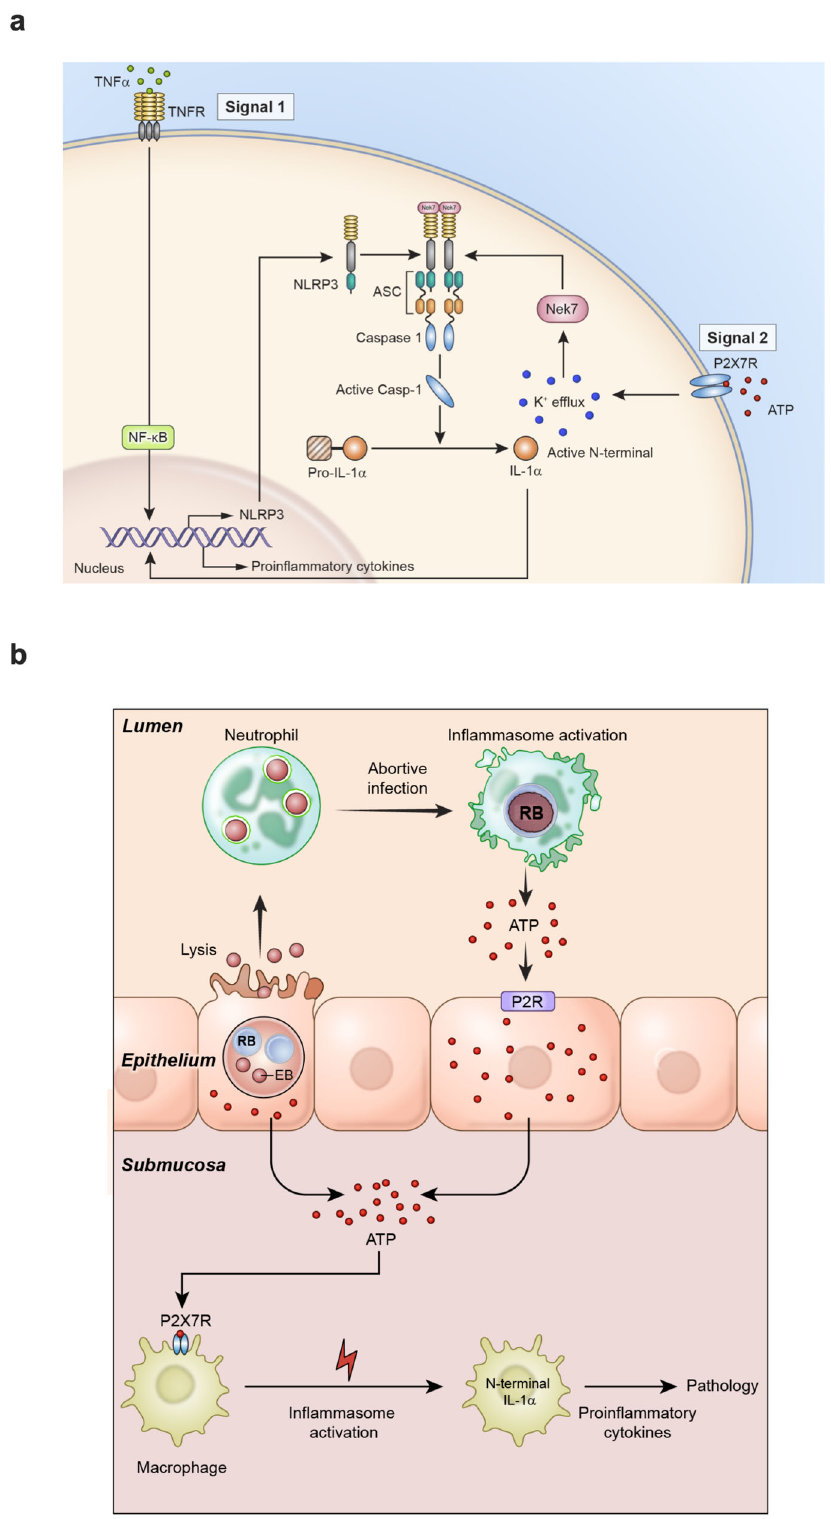
Statistical analyses . GraphPad Prism 7.0 software was used for data analysis. Statistical parameters including the exact value of n , (mean ±SD) and statistical signi fi cance is described in the fi gures. All the graphics used in the fi gures have been created by the authors. No images have been sourced from